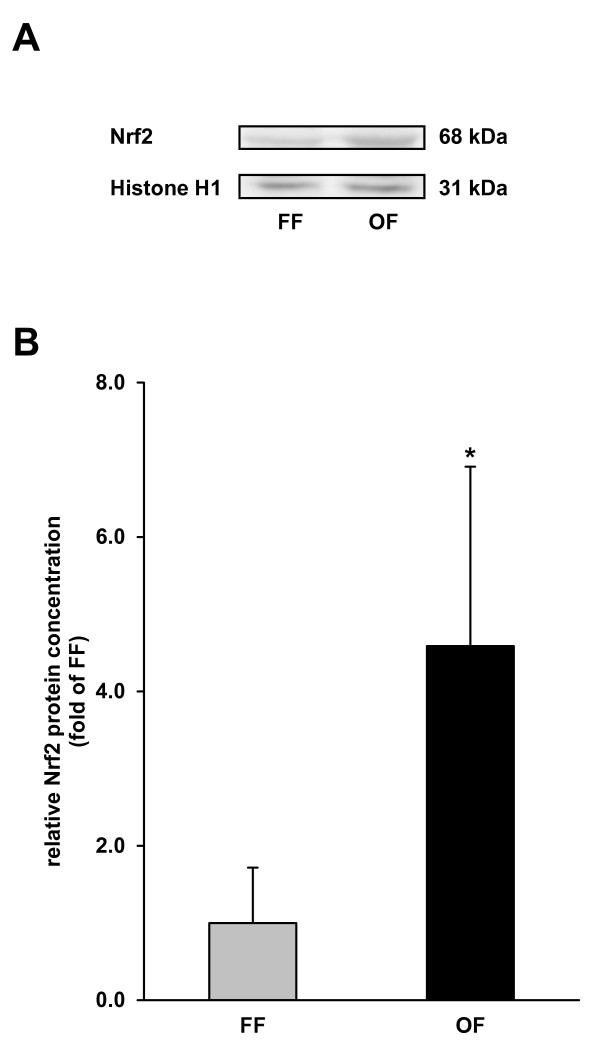
Nuclear concentration of Nrf2 in the liver of pigs fed either a fresh fat or an oxidized fat. (A) Representative immunoblots specific to Nrf2 and Histone H1 for normalization are shown for one sample per group. Immunoblots for the other samples revealed similar results. (B) Bars represent data from densitometric analysis and represent means ± SD (n = 6/group). Bars represent fold of relative protein concentration of the fresh fat group. *Different from pigs fed the fresh fat diet, P < 0.05. FF, fresh fat group; OF, oxidized fat group.